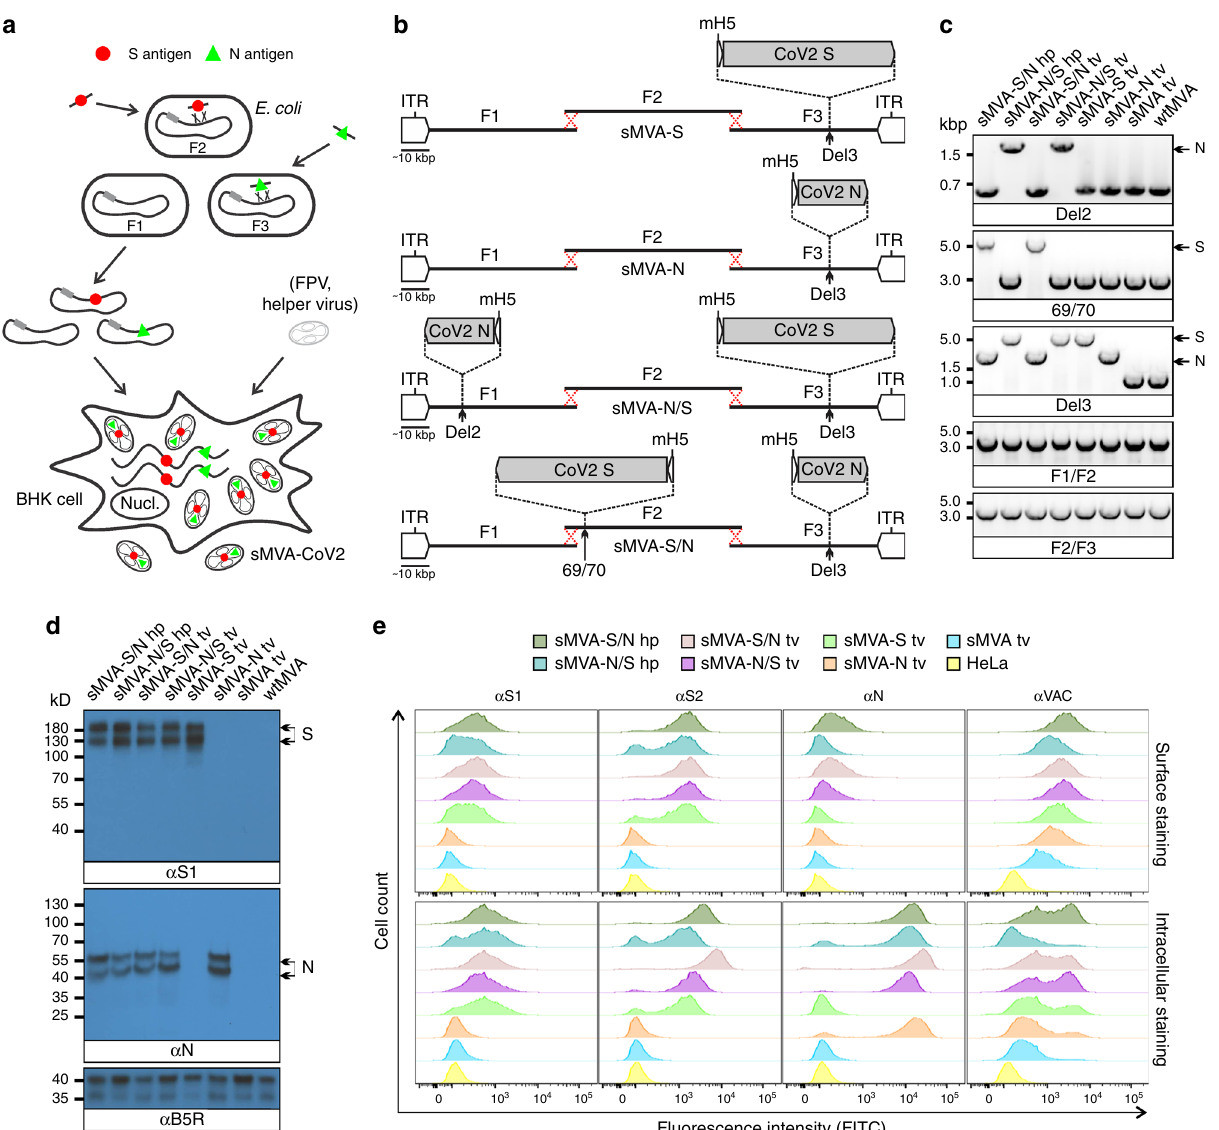
Fig. 4 Construction and characterization of sMVA-CoV2 vectors. a Schematic representation of vector construction. S and N antigen sequences (red spheres and green triangles) were inserted into sMVA fragments F2 and F3 by bacterial recombination methods in E. coli . The modi fi ed sMVA fragments of F2 and F3 with inserted antigen sequences and the unmodi fi ed sMVA fragment F1 were isolated from E. coli and co-transfected into FPV-infected BHK cells to initiate virus reconstitution. b Schematics of single (sMVA-S, sMVA-N) and double (sMVA-N/S, sMVA-S/N) recombinant sMVA-CoV2 vectors with S and N antigen sequences inserted into commonly used MVA insertion sites (Del2, IGR69/70, Del3) as indicated. All antigens were expressed via the Vaccinia mH5 promoter. ITR inverted terminal repeat. c PCR analysis. CEFs infected with the single and double recombinant sMVA-CoV2 vectors derived with FPV HP1.441 (sMVA-S/N hp, sMVA-N/S hp) or TROVAC (sMVA-S/N tv, sMVA-N/S tv, sMVA-S tv, sMVA-N tv) were evaluated by PCR with primers speci fi c for the Del2 and Del3 insertion sites harboring the N and S antigen sequences or primers speci fi c for the F1/F2 and F2/F3 recombination sites. d Western Blot. BHK cells infected with the sMVA-CoV2 vectors were evaluated for antigen expression by Western Blot using anti-S1 and anti-N antibodies ( α S1 and α N). Vaccinia B5R protein was veri fi ed as infection control. Higher and lower molecular weight bands may represent mature and immature protein species. e Flow cytometry staining. HeLa cells infected with the vaccine vectors were evaluated by cell surface and intracellular fl ow staining using anti-S1, S2, and N antibodies ( α S1, α S2, and α N). Live cells were used to evaluate cell surface antigen expression. Fixed and permeabilized cells were used to evaluate intracellular antigen expression. Anti-Vaccinia virus antibody ( α VAC) was used as staining control to verify MVA protein expression. Cells infected with sMVA or wtMVA or uninfected cells were used as controls for experiments in c , d , and e as indicated. The experiments in c , d , and e were performed twice with similar constructs deposited in NCBI and con fi rmed the SARS-CoV-2 vectors, BHK cells infected with sMVA-CoV2 vectors were eval- antigen sequences at the insertion sites, the identity of the MVA uated by Immunoblot using S- and N-speci fi c antibodies. This genome, and removal of the BAC vector sequences. analysis con fi rmed the expression of the S or N antigen alone by the single recombinant vaccine vectors sMVA-S and sMVA-N, while the expression of both the S and N antigens was con fi rmed for the In vitro characterization of sMVA-CoV2 vaccine vectors . To double recombinant vectors sMVA-N/S and sMVA-S/N (Fig. 4d). characterize S and N antigen expression by the sMVA-CoV2